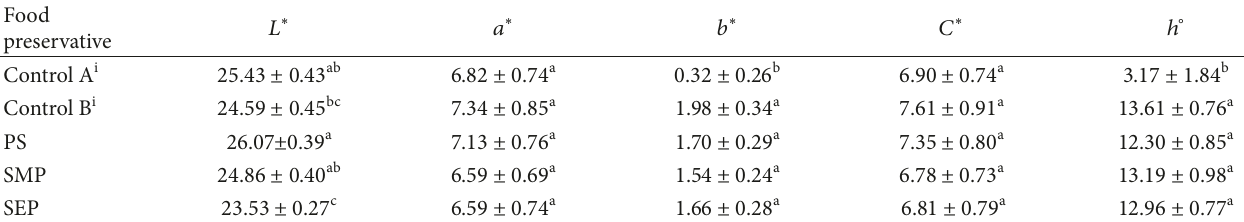
Table 1: Color values of “Friar” plums uncoated or coated with hydroxypropyl methylcellulose-beeswax edible coatings containing potassium sorbate (PS), sodium methyl paraben (SMP), or sodium ethyl paraben (SEP) and stored for 22 d at 1 ∘ C followed by 5d at 20 ∘ C.